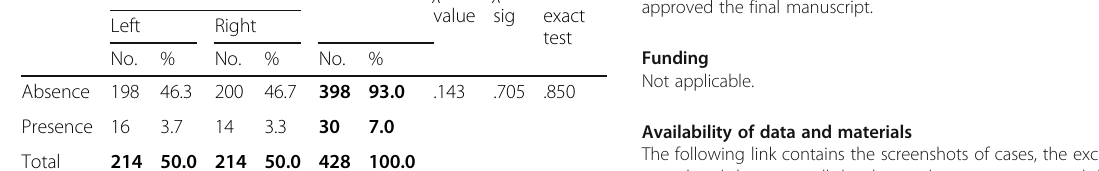
Fisher ’ s value sig exact